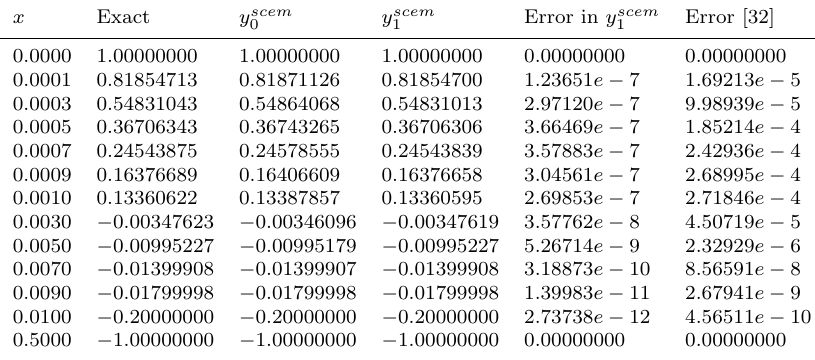
Figure 4. Absolute errors in SCEM approximations y sceml boundary layer in solving non-homogeneous problem (4.7)–(4.8); ε = 0 . 01. The second SCEM approximation is superior over the first